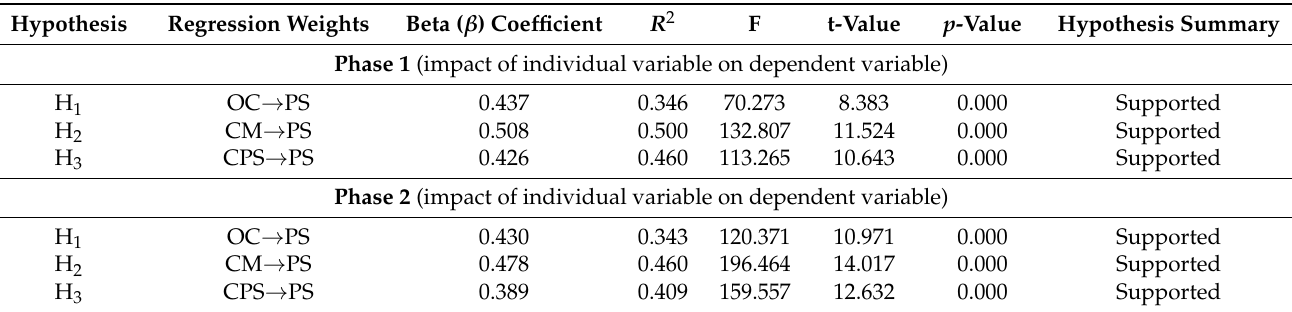
Table 6. Linear regression